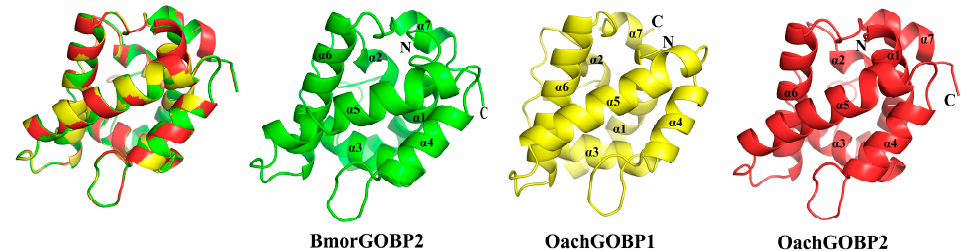
Figure 5. 3-D Structural modeling of OachGOBPs. Superposition of the three GOBPs in the same